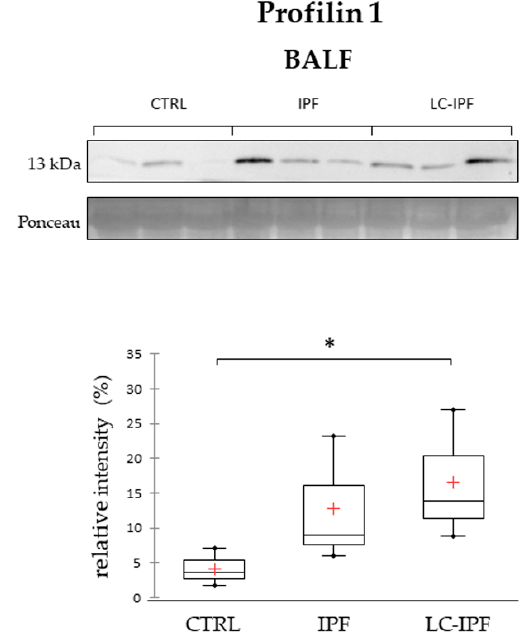
Figure 6. Western blot analysis of profilin 1 in BALF samples. Statistical analysis was performed by